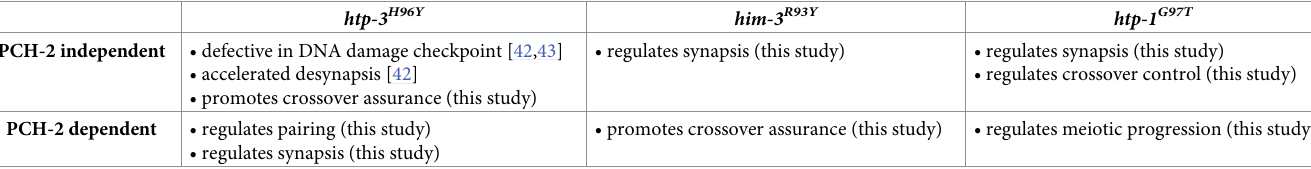
Table 2. Summary of phenotypes associated with meiotic HORMAD mutations described in this